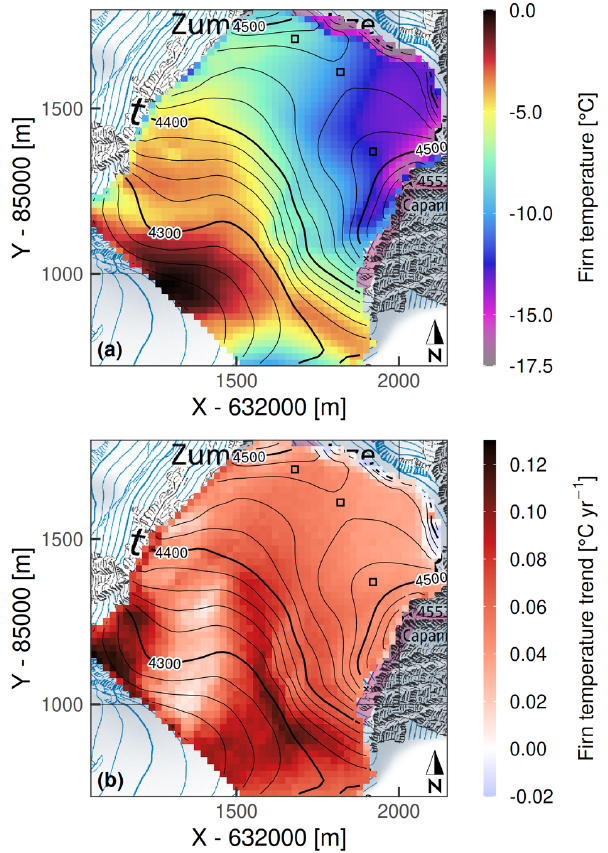
Figure 7. (a) Modeled 20m firn temperatures on 31 Decem- ber 2018. (b) Modeled 20m firn temperature trends over 2003– 2018. In both panels, marked cells correspond to the representative points of Fig. 1a. x and y are metric CH1903/LV03 coordinates. Topographic map source: Federal Office of Topography swisstopo.